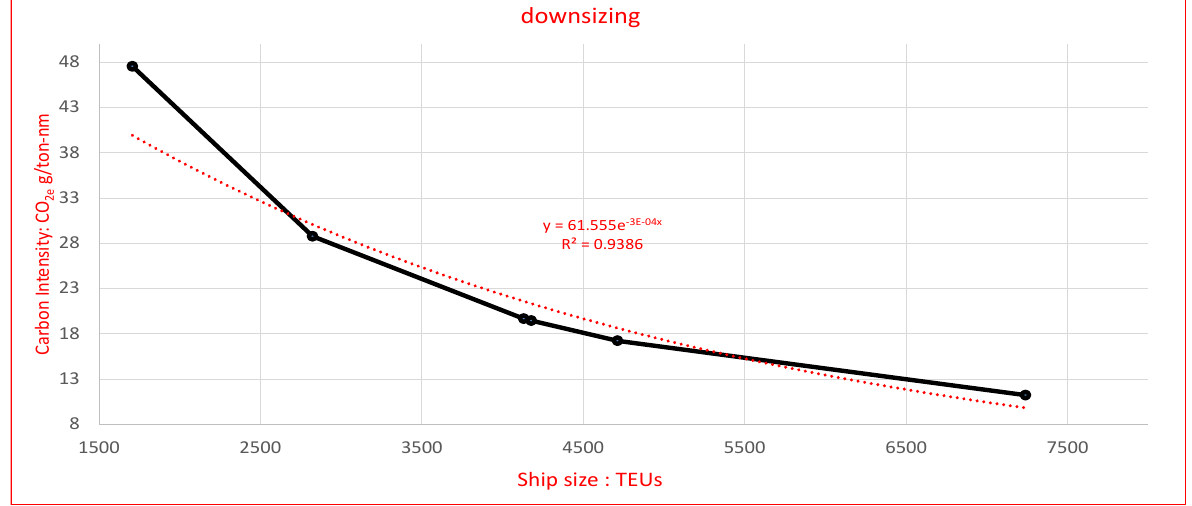
Figure 5. The Carbon Intensity against Ship Size of Route B-2.